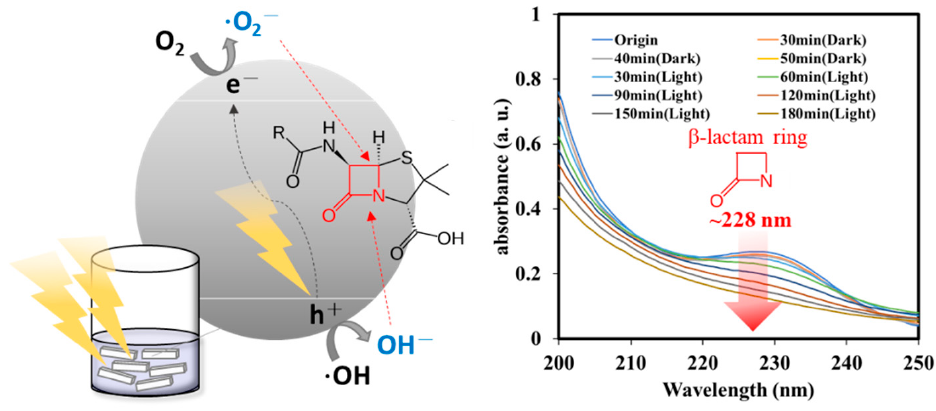
Figure 8. The possible photocatalysis mechanism for the photocatalytic degradation of